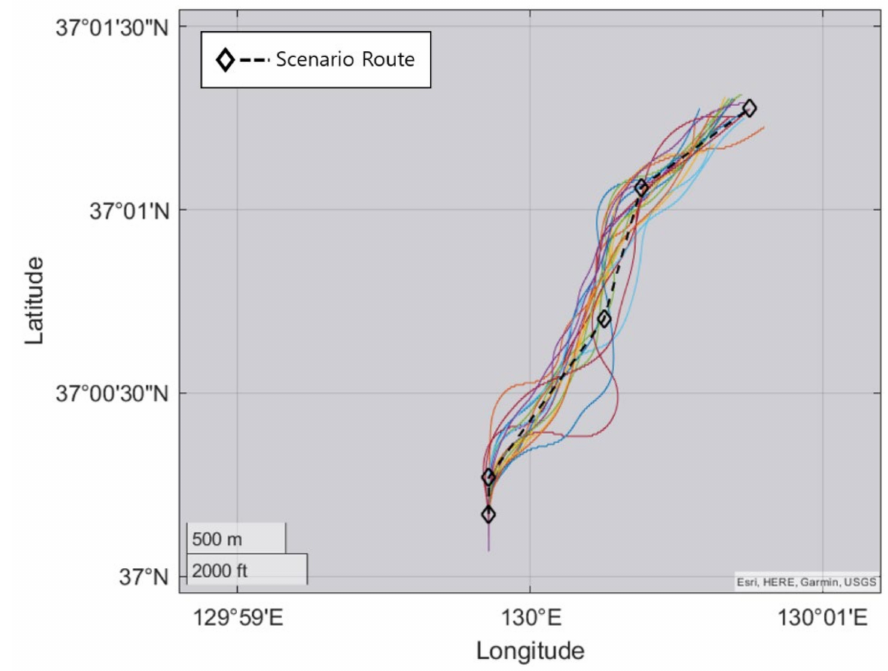
Figure 5. Navigation performance result: group A.